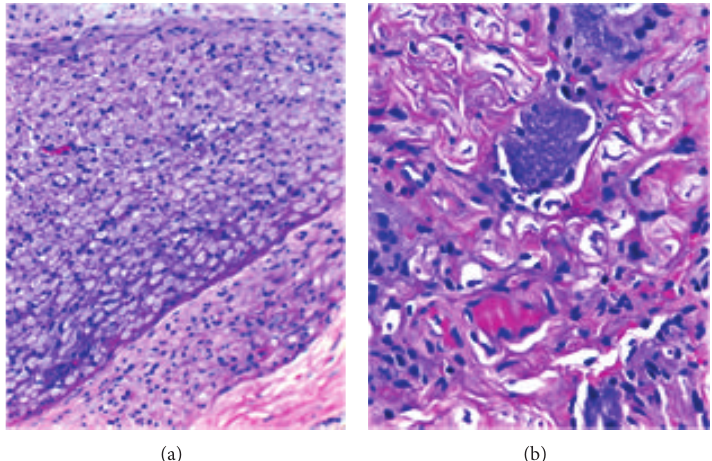
Figure 8: (a and b) Biphasic pattern with cellular Antoni A and hypocellular Antoni B areas. Compact fascicles of elongated tumor cells with slight nuclear polymorphism. Hyalinized vessels.